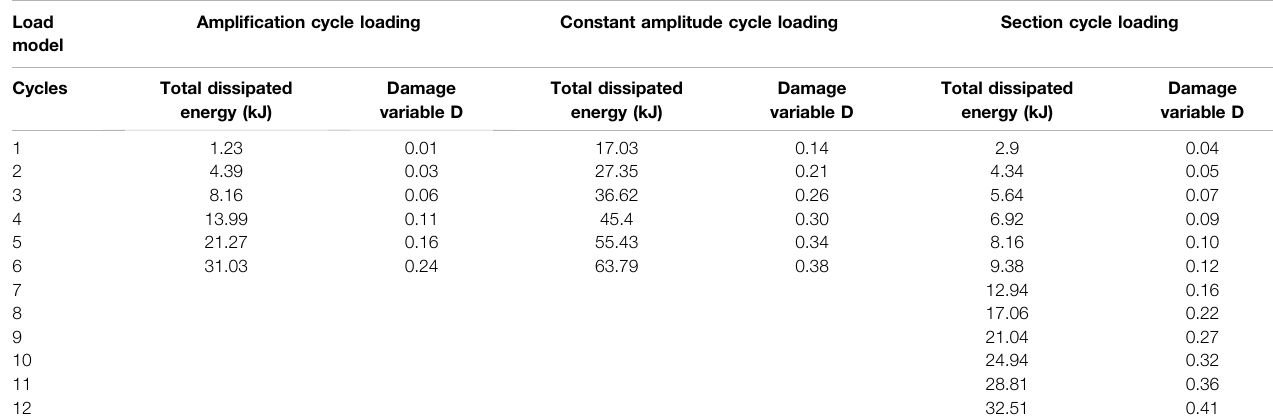
TABLE 3 | Calculation of damage variables of coal samples for different cyclic loading paths.